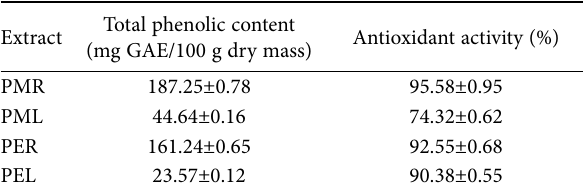
Table 1. Total phenolic content and antioxidant activity of the etha- nol and methanol extracts of Polystichum setiferum (Forssk.) Moore ex Woyn.